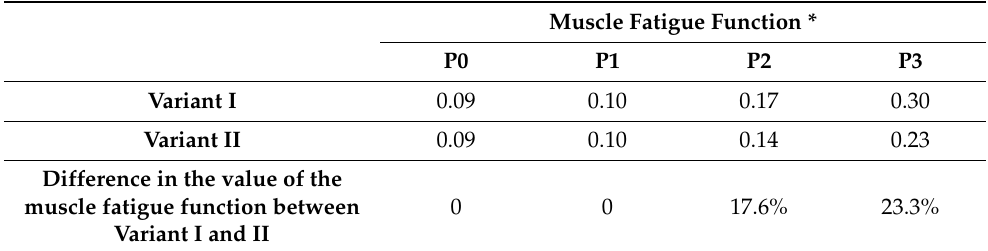
Table 3. Changes in the muscle fatigue function during measurement sessions: P0—before pregnancy, P1—in the first trimester, P2—in the second trimester, P3—in the third trimester of pregnancy.